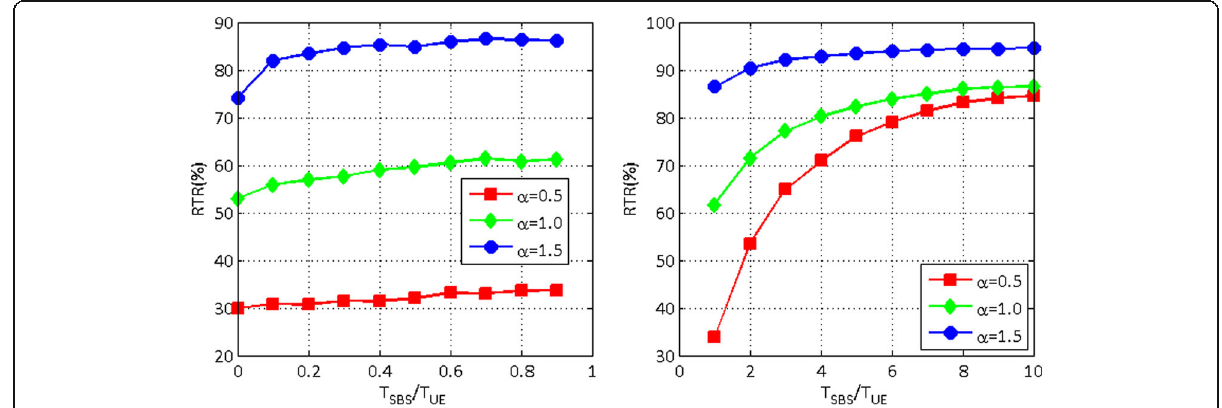
(cid:3) T UE and Zipf parameter to RTR (